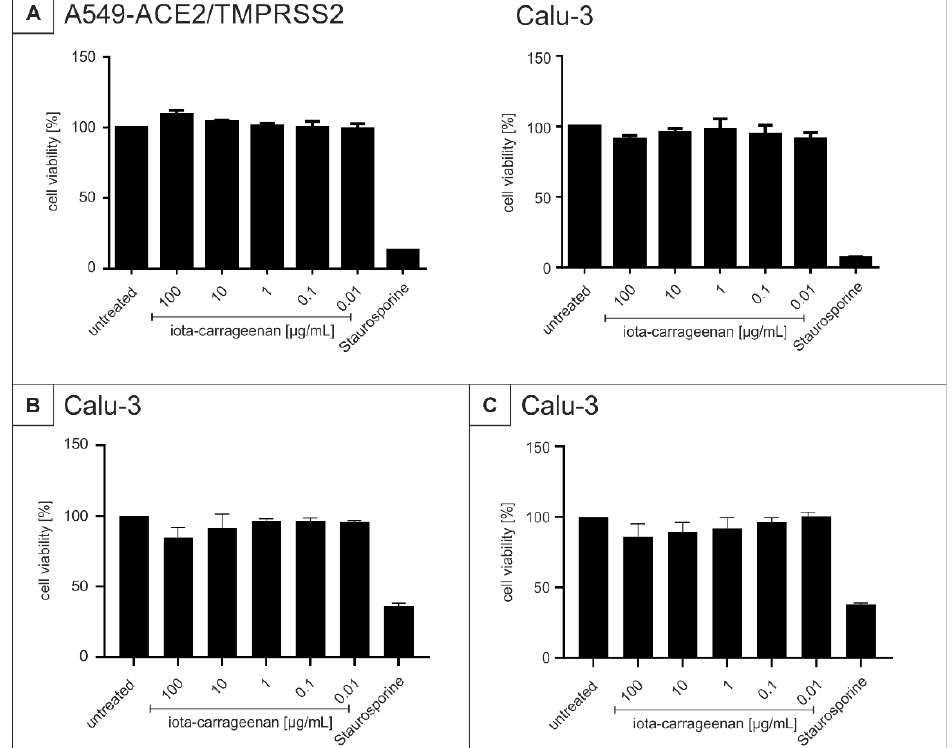
Figure 4. Influence of iota- ( A ), kappa- ( B ) and lambda-carrageenan ( C ) on the cell viability of A549-ACE2/TMPRSS2 cells and Calu-3 cells. Following treatment with different concentrations of carrageenan (iota-carrageenan concentrations are indicated at the x -axis) for three days, the influence on cell viability was measured by water-soluble tetrazolium salt (WST)-1 assay. Bars represent means of three independent experiments ± SD. Staurosporine (1 µM) was used as a positive control.